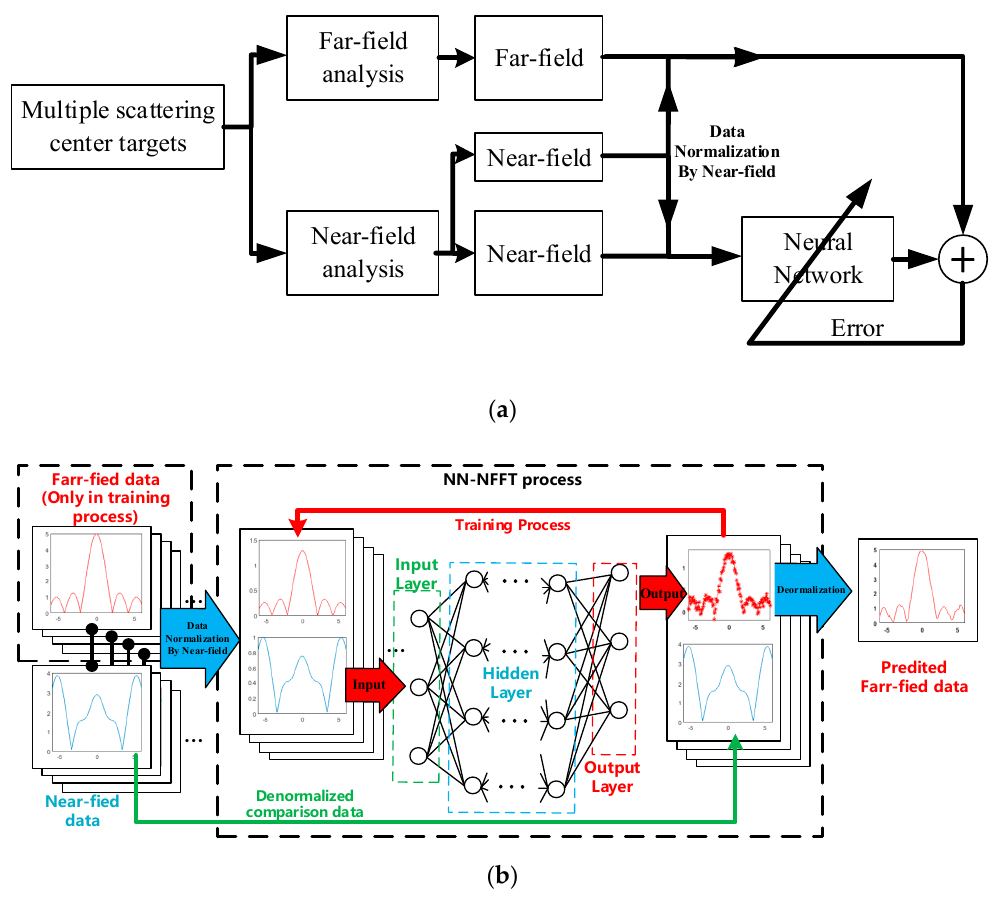
Figure 4. Neural network flow chart ( a ) NN-NFFFT training scheme ( b ) the structure of NN-NFFFT framework.